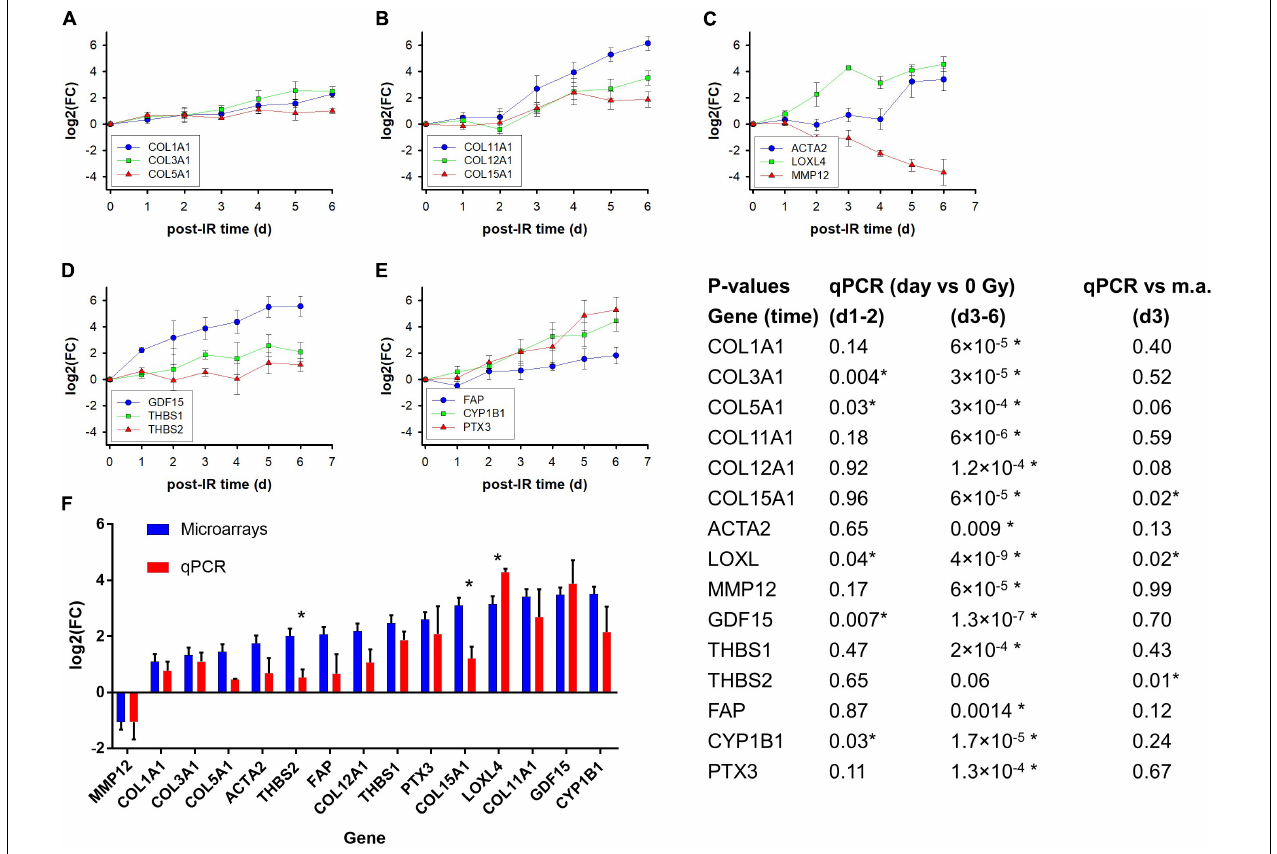
fibroblast strains was 2.6-fold [mean log2(FC) = 1.36 ±